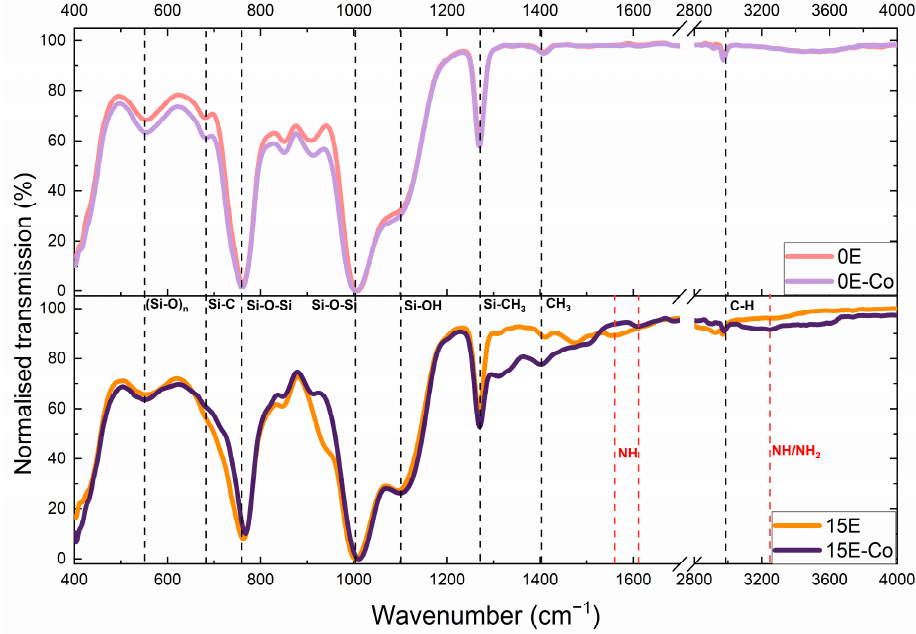
Figure 5. FTIR spectra of the cobalt-modified aerogels and the reference cobalt-free aerogels (0 mol.% and 15 mol.% of EDTMS).